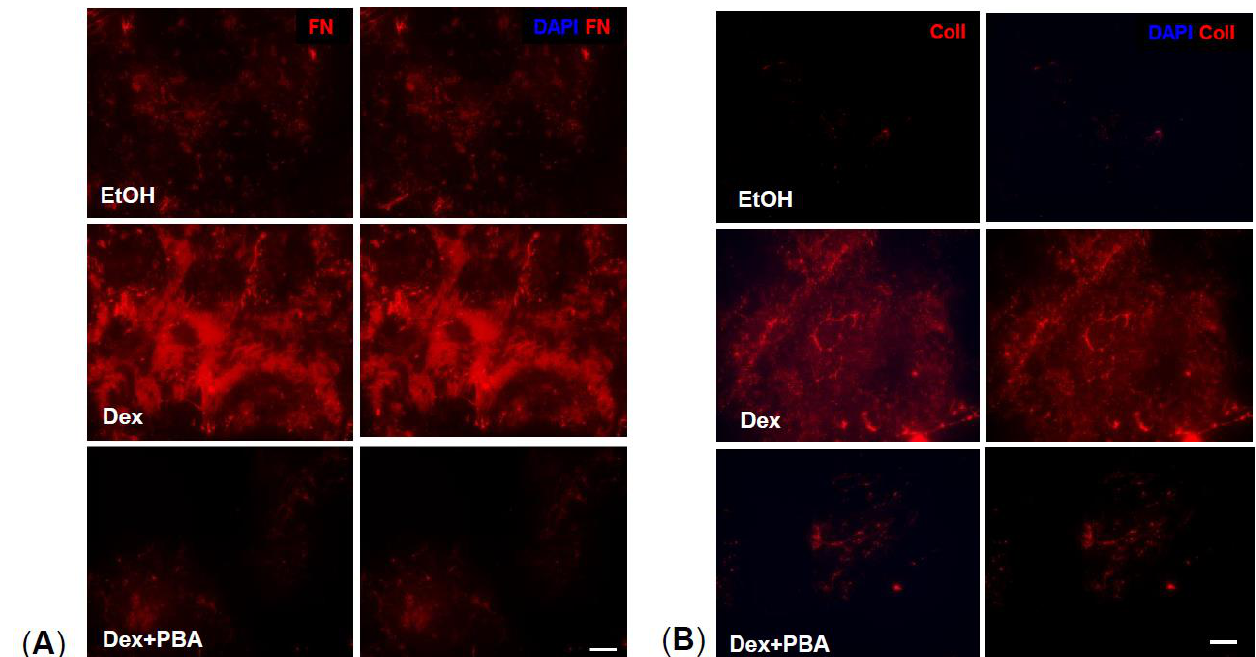
Figure 3. PBA reduces Dex-induced abnormal ECM deposition: Primary human TM cells were grown to 80% confluency on a 4-well glass chamber slides and treated with either ethanol, Dex (100 nM) and Dex + PBA (5 mM) for 7 d. Following decellularization with Tritox-100 and NH 4 OH, wells were stained with ECM markers (FN and ColI) and DAPI. Absence of DAPI further confirmed the successful decellularization process. An increased extracellular deposition of FN ( A ) and ColI ( B ) was observed in Dex-treated cells compared to Veh-treated cells. However, in Dex + PBA treated cells, a prominent decline in ECM deposition was observed (Scale bar 50 µm).